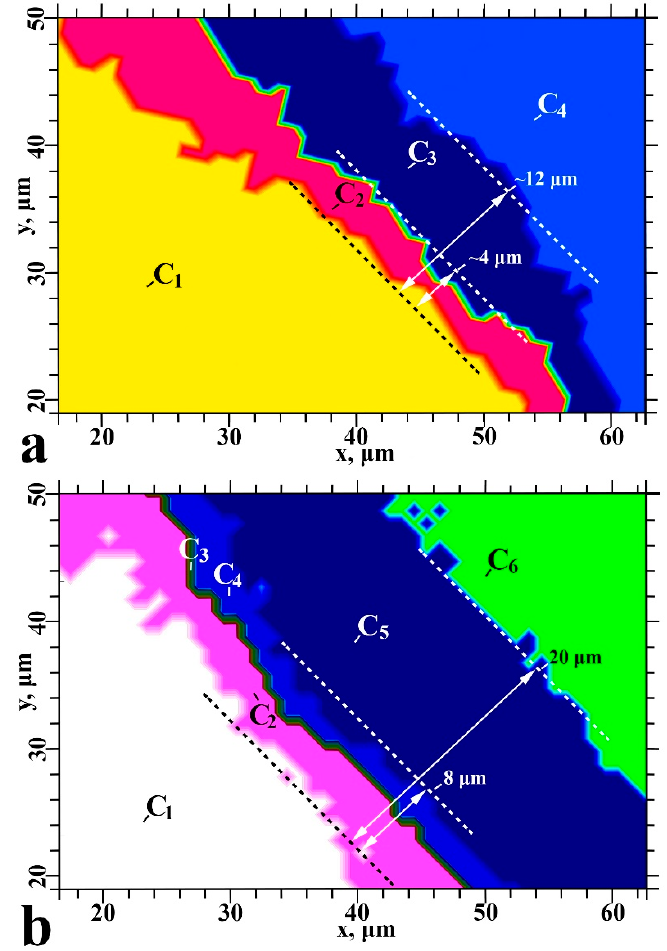
Figure 4. Cluster analysis for type I ( a ) and type II ( b ) samples. Colour-coded clusters (C 1 –C 4 and C 1 –C 6 for type I and II samples, respectively) were defined from the spectra using Ward’s method.